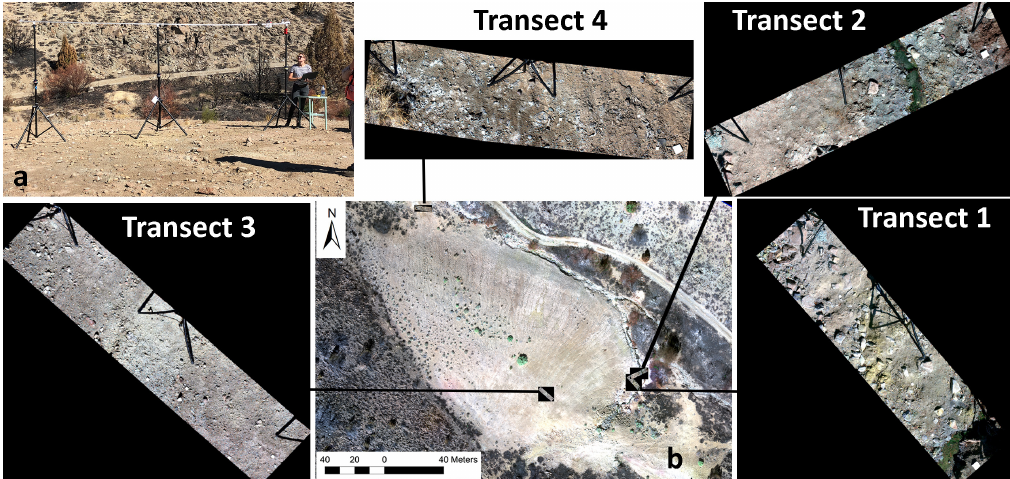
Figure 3. ( a ) Custom-built motion-control system used for the Hyperspectral Surveys. ( b ) September 2018 UAS survey displaying locations for Transects 1–4 on the Jones-Kincaid waste cover, with zoomed images of Transects 1–4 using approximate true color RGB wavelengths (668 nm, 560 nm, 475 nm). Each Transect is 1.3 m wide, 5.5 m long.